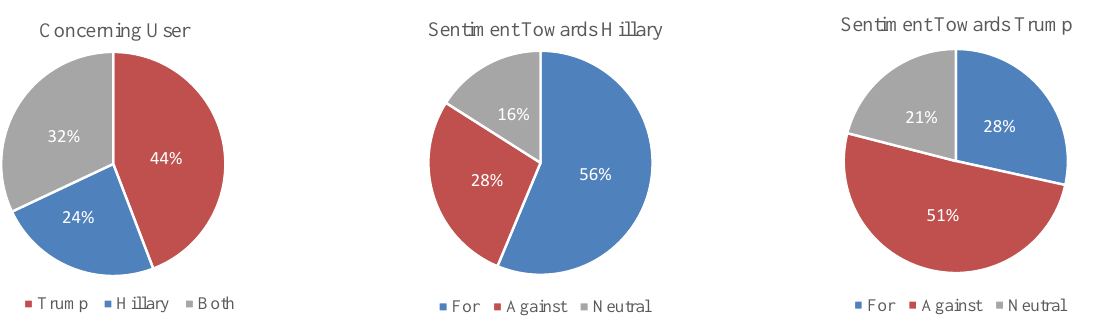
Figure 6. An illustration of the dataset composition. Noting that “ Concerning User ” refers to the user whose tweets contain content about the corresponding